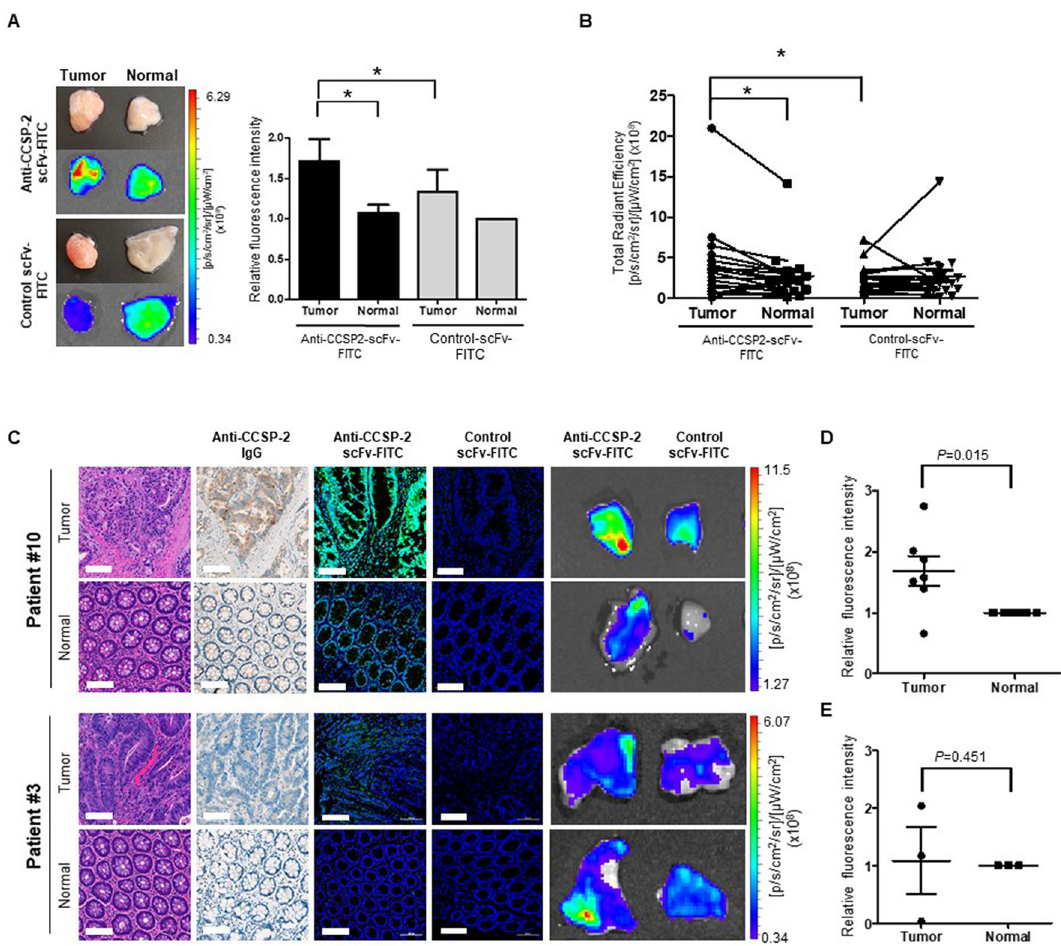
Figure 4. Ex vivo molecular imaging of tumor tissues from colorectal cancer patients. ( A ) Representative ex vivo fluorescence imaging and relative fluorescence intensity graph of colorectal cancer patient specimens treated with FITC-conjugated anti-CCSP-2 scFv and control scFv (* p < 0.05). ( B ) Total fluorescence intensity of each patient specimen treated with FITC-conjugated anti-CCSP-2 scFv and control scFv (* p < 0.05). ( C ) tissues with strong expression of CCSP-2 (n = 7). ( E ) Relative fluorescence intensity of patient tissues with weak expression of CCSP-2 (n = 3). Data shown are the mean ± standard error of the mean